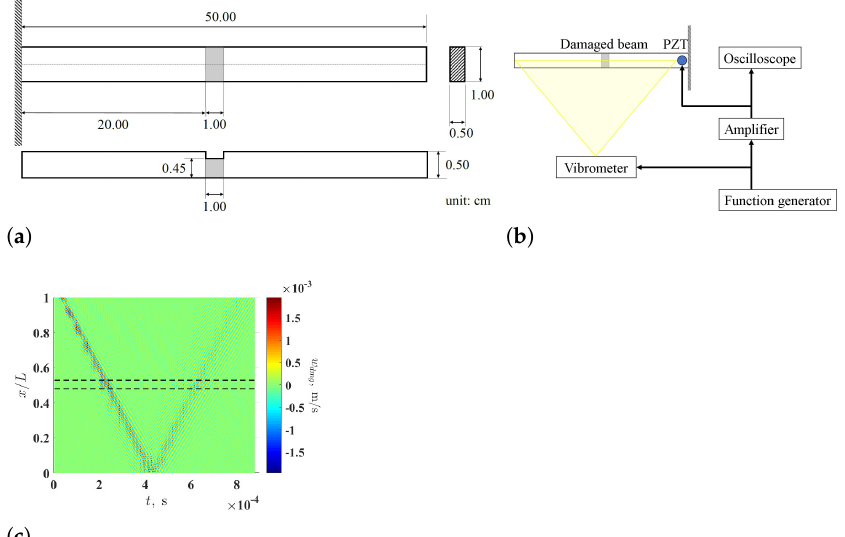
Figure 7. ( a ) Dimensions of a tested damaged cantilever beam with damage in the form of a one- sided thickness reduction area, ( b ) a schematic of the experimental setup for exciting and measuring a propagating flexural wave of the damaged beam, and ( c ) the denoised measured propagating flexural wave of the damaged beam, where the locality and extent of the damage are indicated by two dashed